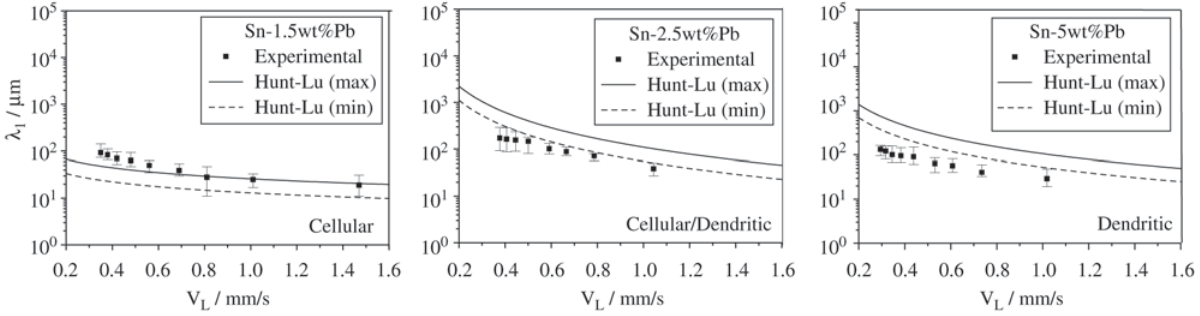
Figure 5. Comparison between theoretical and experimental values of cellular/dendritic spacings.